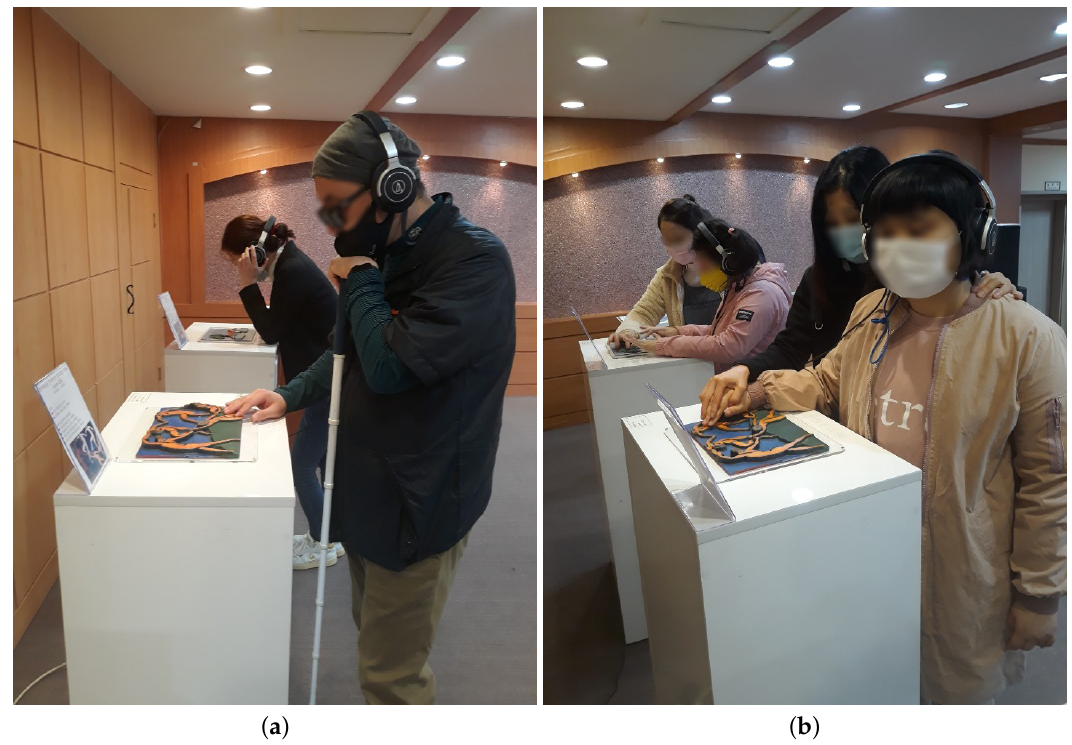
Figure 5. Exhibition visitors using the interactive multimodal guide. ( a ) Stand alone use ( b ) Social